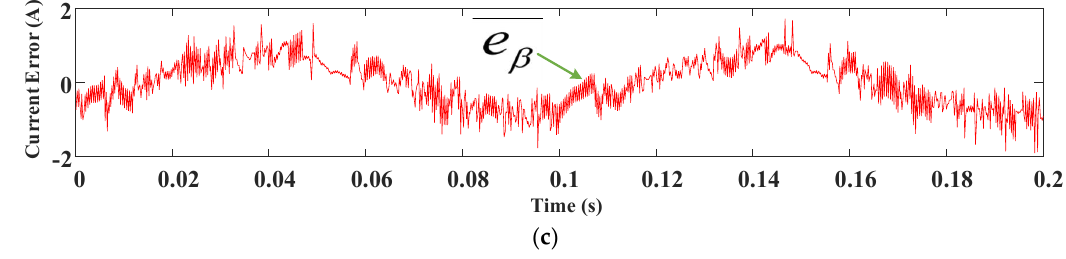
Figure 8. Experimental results of SVV-MPCC under speed 300 rpm and load 2 Nm (case 1): ( a ) current responses; ( b ) α -axis current error; ( c ) β -axis current error.